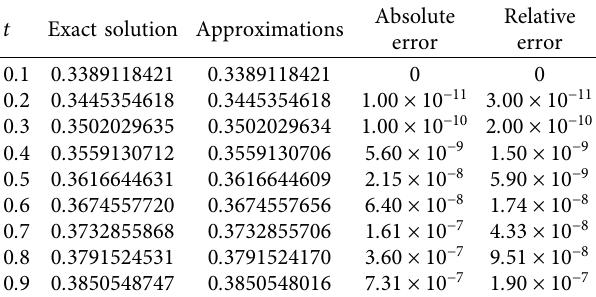
Table 5: Numerical results of 5 th FRPS at α � 1 for Example 2 .